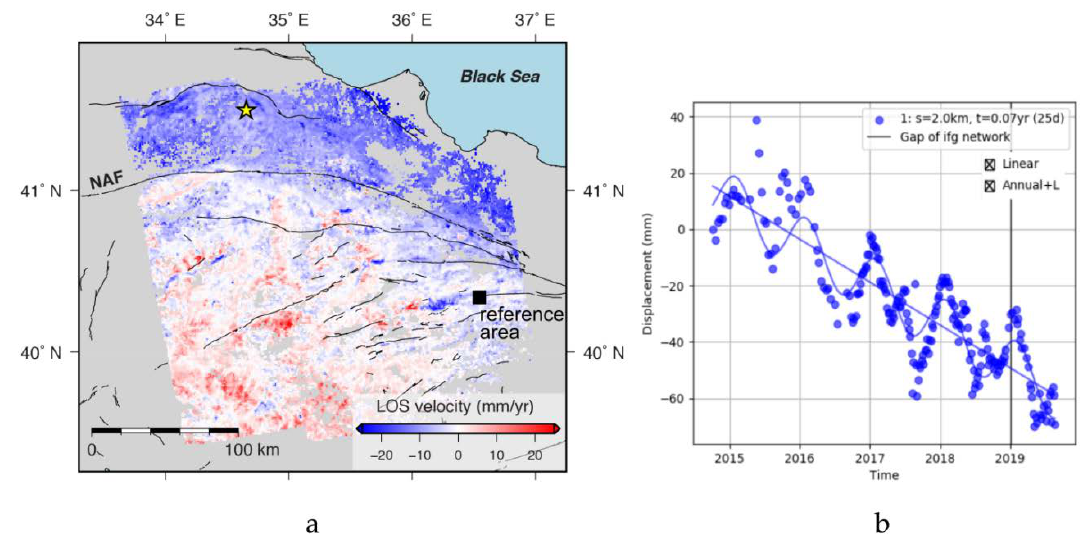
Figure 11. Line of sight (LOS) velocity map and time series for frame 014A_04939_131313, which corresponds to a region around the North Anatolian Fault (NAF). ( a ) Velocity map with active faults [67]. Black square is the reference area used for the velocity field determination. Yellow star is the location of the time series shown in ( b ). ( b ) Displacement time series from the location corresponding to the yellow star in ( a ) relative to the reference area. The best-fit linear and annual seasonal trends are overlain on the time series. The sizes of the spatial and temporal filters are 2 km and 25 days, respectively.